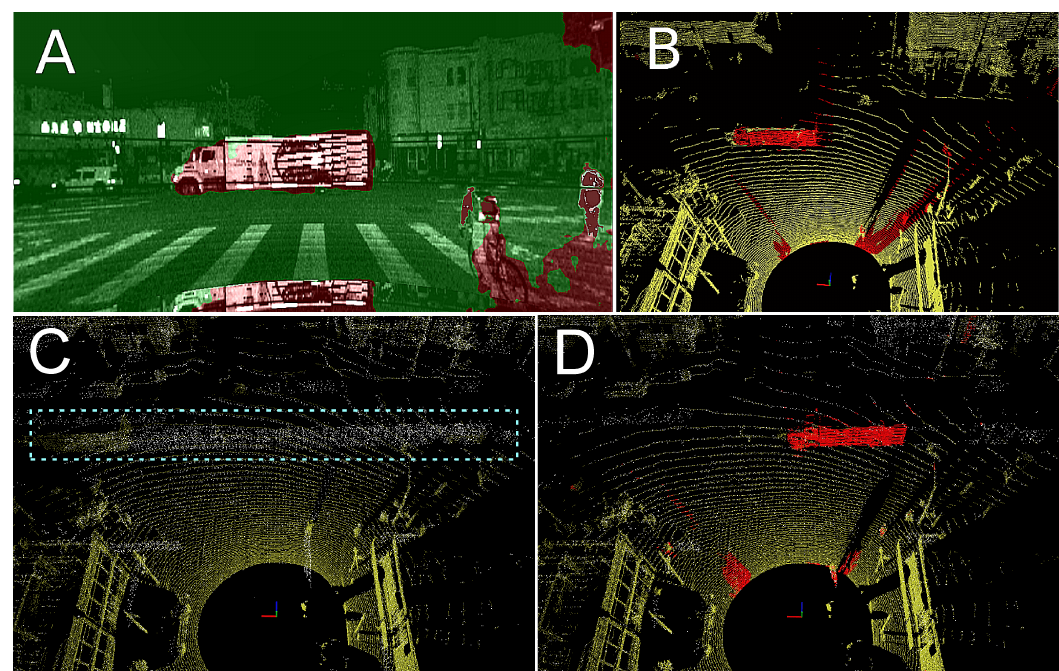
Figure 1. Motivational example of non-stationary objects segmentation and removal on a short sequence from Ouster OS1-128: segmented intensity image ( A ), rejected points (red) in a single scan ( B ), and the resulting map without ( C ) and with ( D ) the proposed method of rejecting non-stationary objects. Note that the slowly moving large truck left a wake of invalid points in the map (blue rectangle), which is not present in the map if the rejection method is